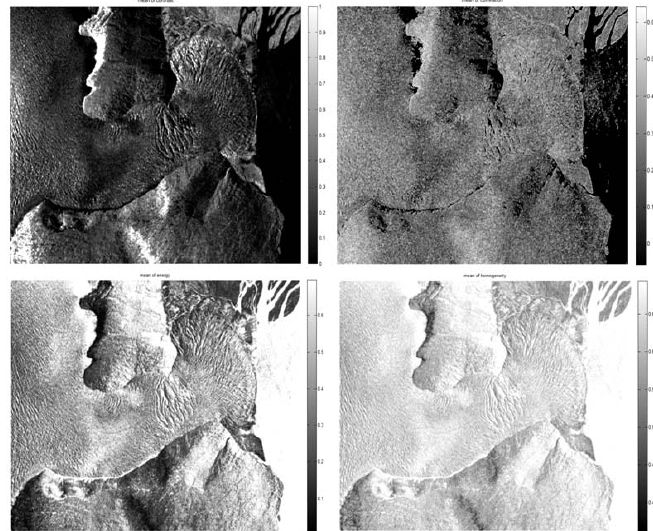
Fig.6. Upper left: mean value of contrast. Upper right: mean value of correlation. Lower left: mean value of energy. Lower right: mean value of homogeneity.